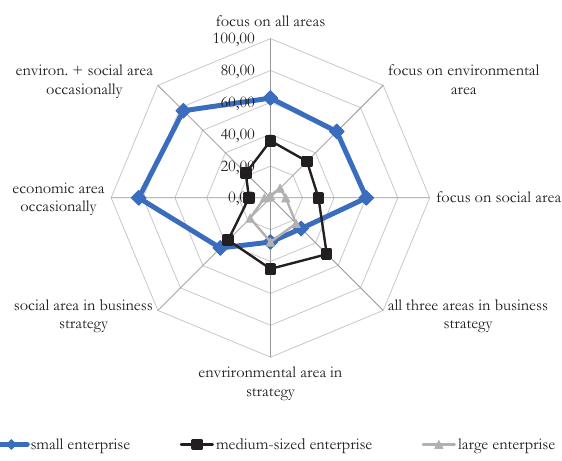
Fig. 3 - The business focus on corporate sustainability concept areas according to the enterprise size. Source: